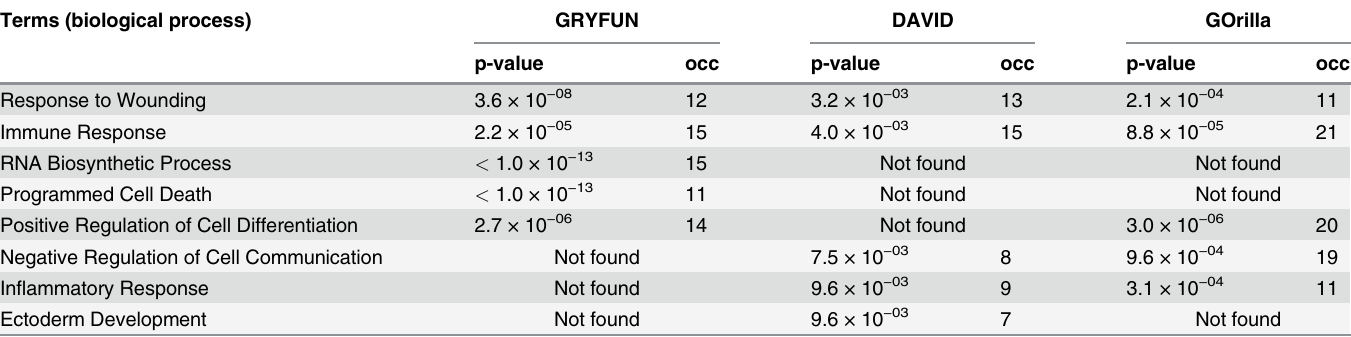
Table 5. Comparison of GO term enrichment analyses of micro-array data by GRYFUN, DAVID and GOrilla. Selected examples of GO terms found to be enriched in list of differentially expressed genes (upregulated in cystic fi brosis nasal epithelium [25]) by GRYFUN, DAVID or GOrilla. Occurrence (occ) numbers and p-values are shown. “ Not found ” means the GO term was not considered signi fi cant. Terms (biological